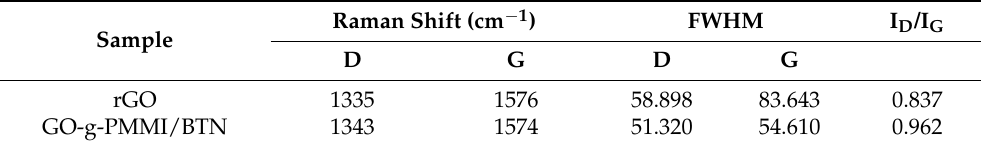
Figure 3. Raman spectrum of rGO and GO-g-PMMI/BTN. Table 2. Values of I D /I G , FWHM and the Raman shifts of the D-band and G-band.